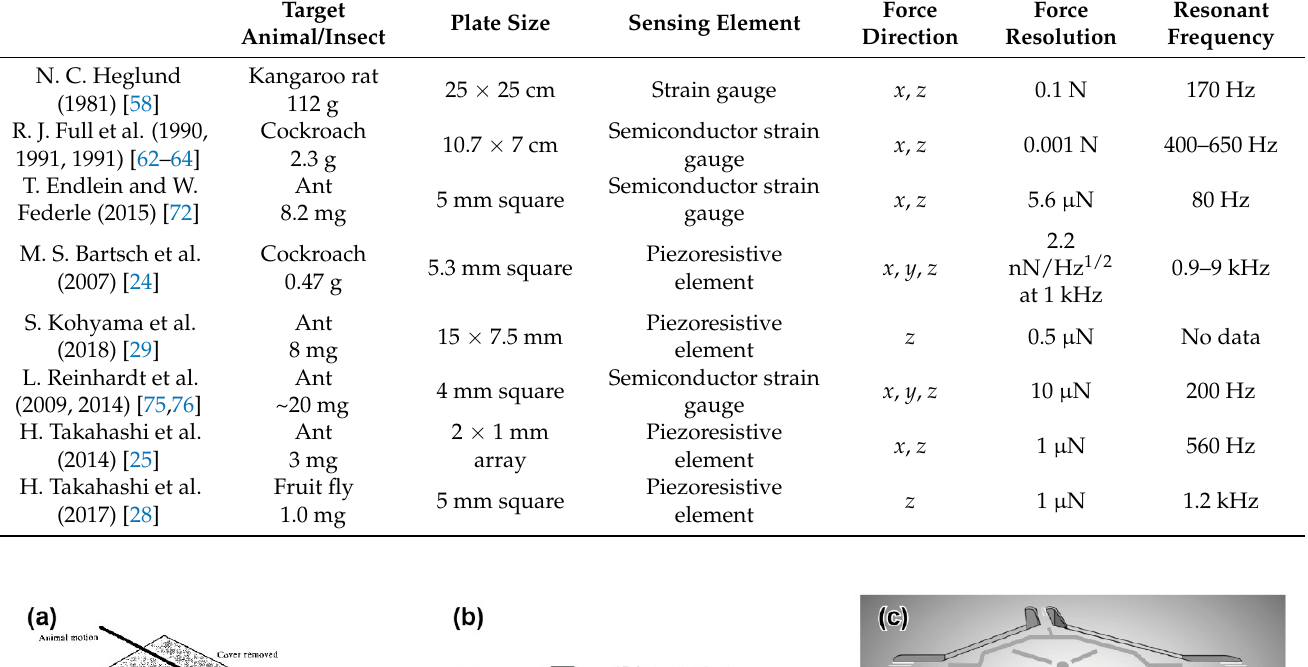
Table 1. Specifications of the developed force plates. The force plates were designed according to the size and motion of the measurement target.